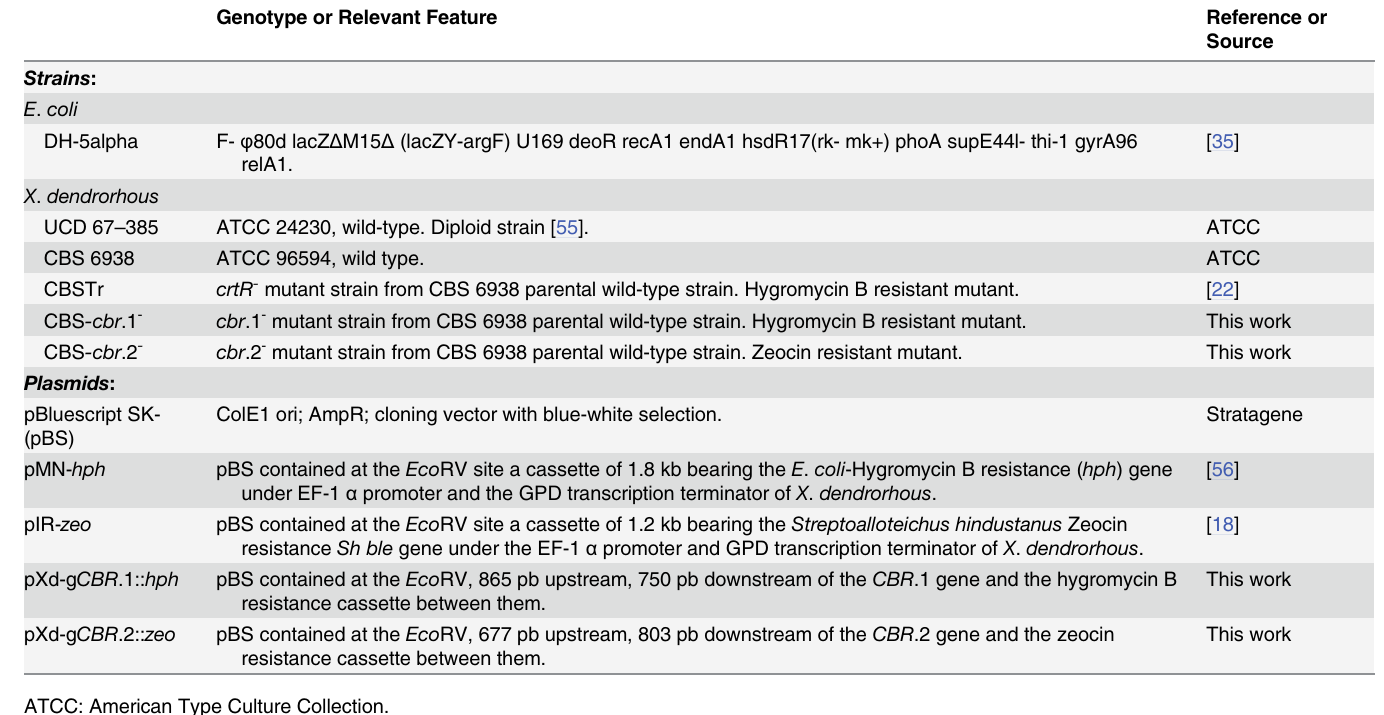
Table 1. Strains and plasmids used and/or constructed in this work. Genotype or Relevant